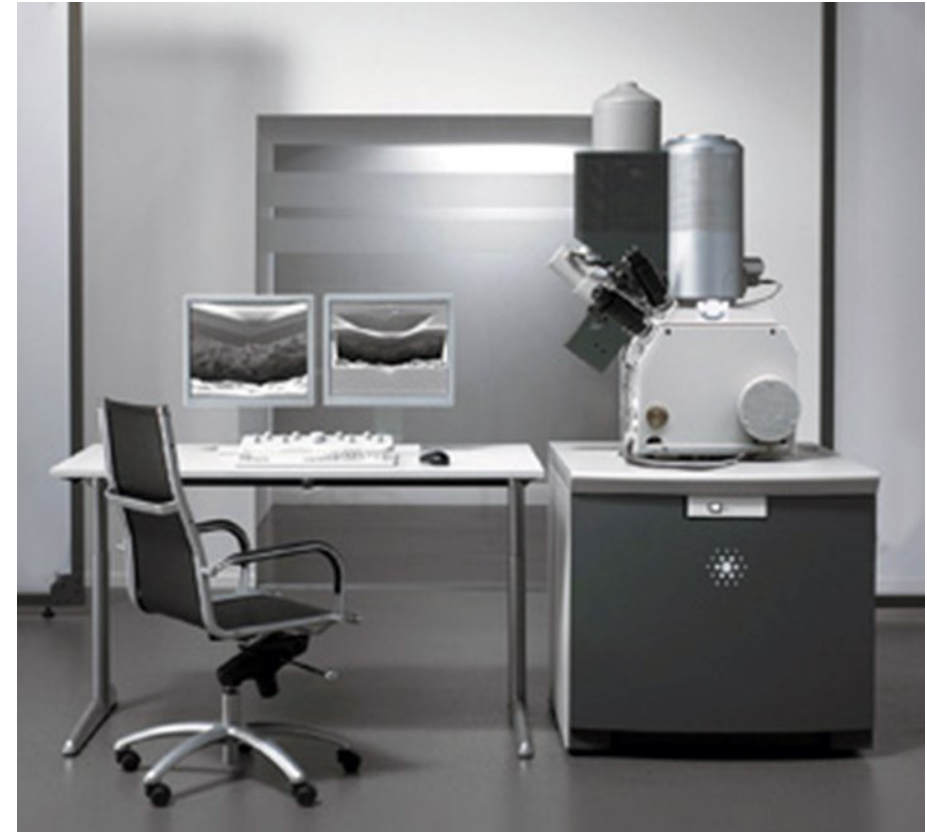
Figure 1: FEI Helios NanoLab™ 400S FIB-SEM (photograph by courtesy of FEI